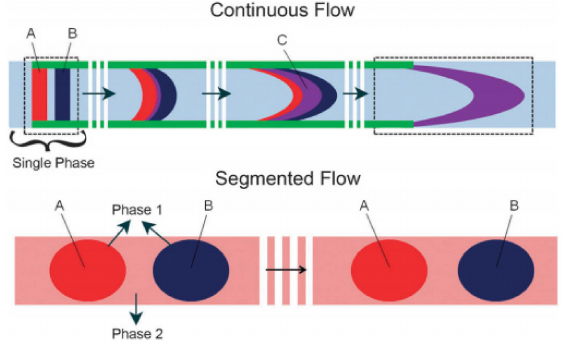
Figure 1. Schematic representation of using segmented flow to avoid the Taylor dispersion. (The vertical white lines represent the passage of space and time (Reprinted with permission from Reference [8]. Copyright 2011 Royal Society of